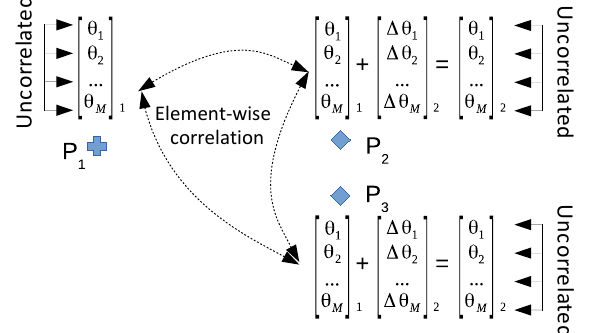
Figure 3. Schematic of random phase angle vectors and determin- istic phase